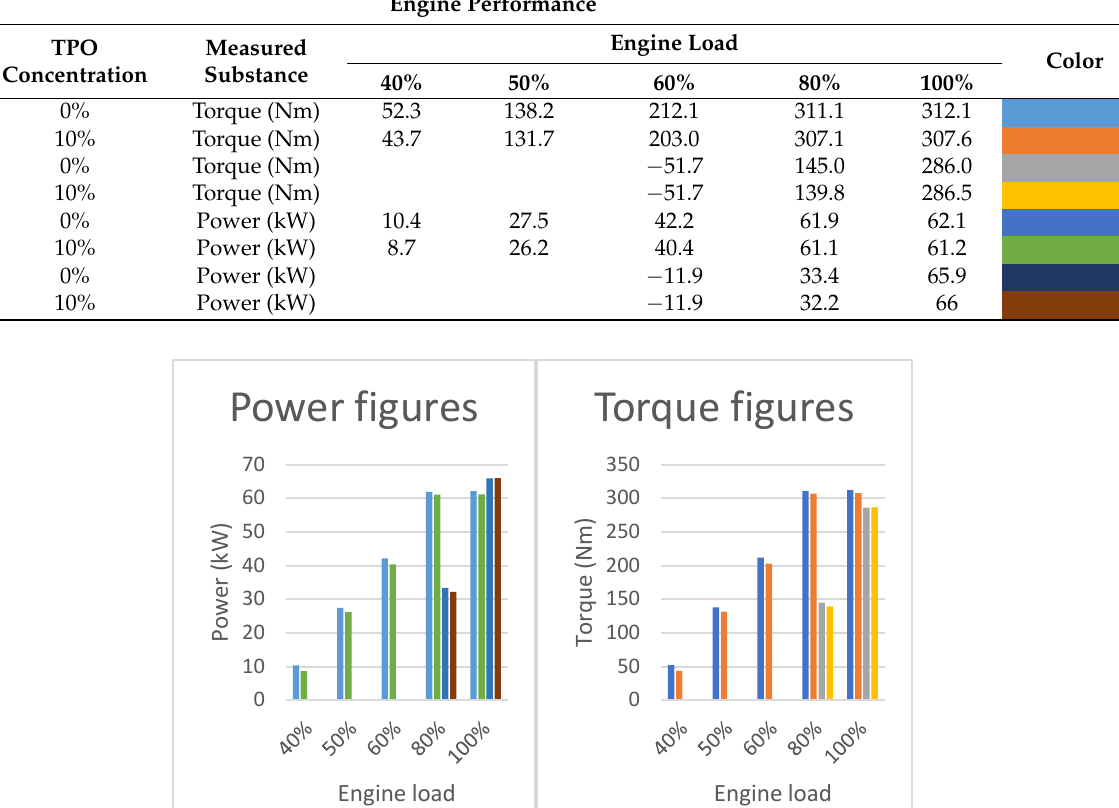
Table 4. Measured engine performance.